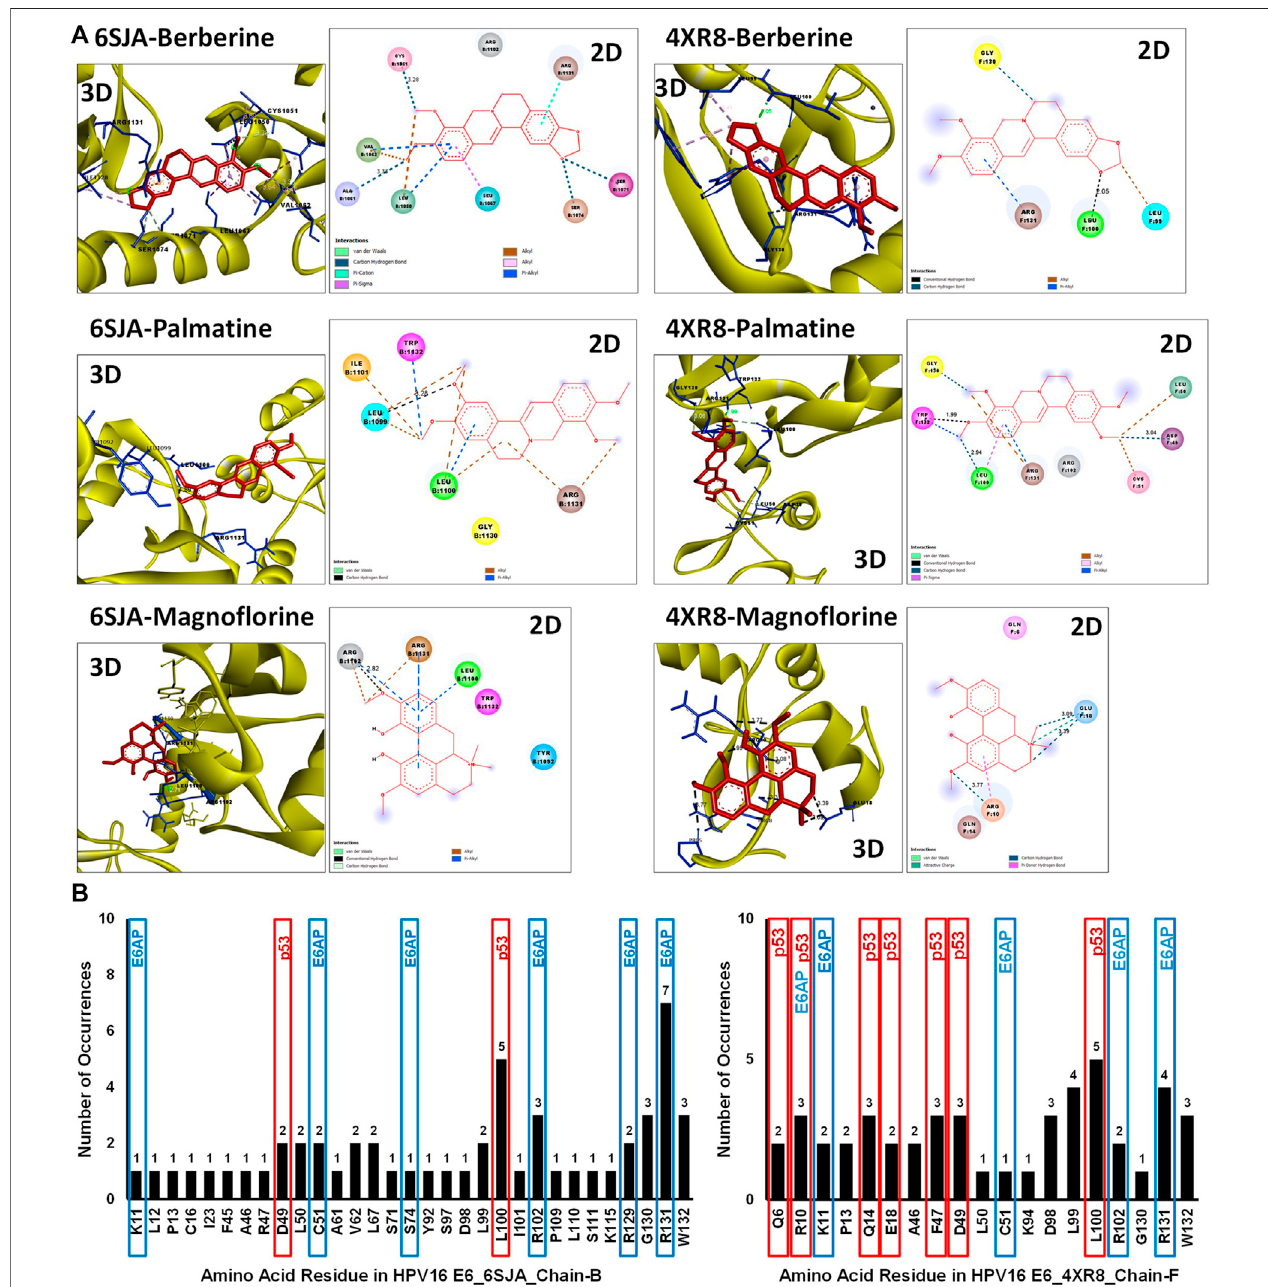
FIGURE6| Moleculardockingofkeyphytochemicalsreportedin B.aquifolium rootwithHPV16E6anditsimpactoftheirbindingonE6 ’ scarcinogenicinteraction. (A) . Best ranked docking pose (3D) and a 2D simpli fi ed representation of the binding pockets of three best leads, berberine, palmatine and magno fl orine, in association withHPV16E6(basedon6SJA( leftpanel )or4XR8( rightpanel )crystalstructure)showinginteractingresiduesandnon-covalentinteractions.Thehydrogenbondsare shown as dashed lines. (B) . Graphical representation of the cumulative data showing number of times an amino acid residue of HPV16 E6 (6SJA ( left panel ) or 4XR8 ( right panel )) appeared in the binding pocket of different phytochemical ligands examined. The residues identi fi ed in molecular docking that are involved in key carcinogenic interactions with p53 or E6AP are highlighted with different colored boxes.